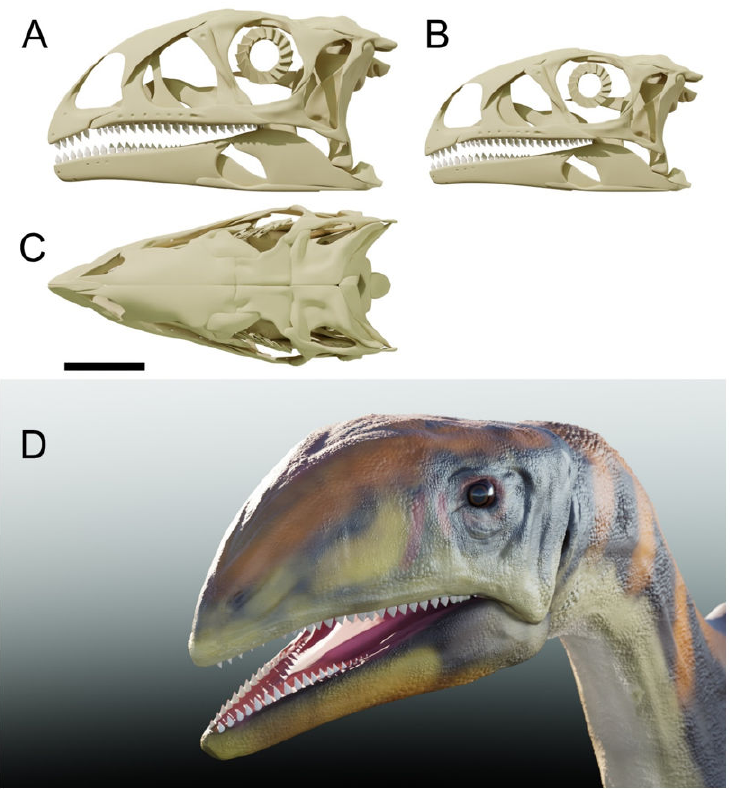
Figure 38. Digital interpretative reconstruction of the skulls NHMD 164741 and NHMD 164758 and living representation of Issi saaneq . ( A ) Digital interpretative reconstruction of the skull NHMD 164741 in left lateral view. ( B ) Digital interpretative reconstruction of the skull NHMD 164758 in left lateral view. ( C ) Digital interpretative reconstruction of skull NHMD 164741 in dorsal view. ( D ) Living representation of Issi saaneq . Scale bar = 50